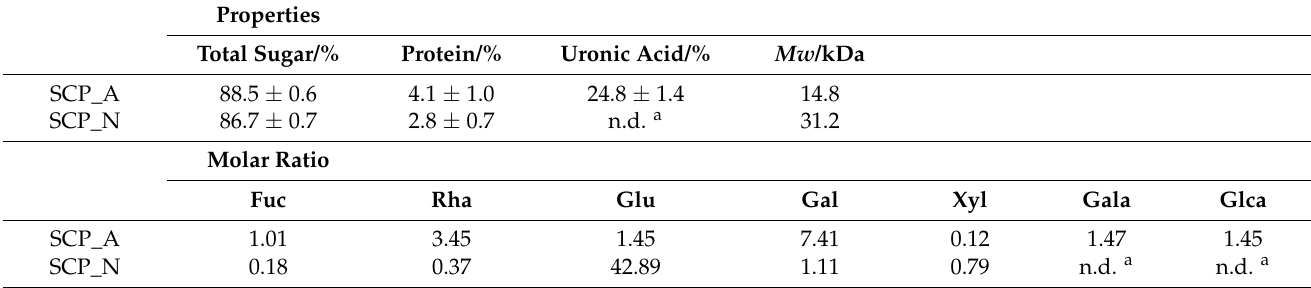
Table 2. Chemical composition of SCP_A and